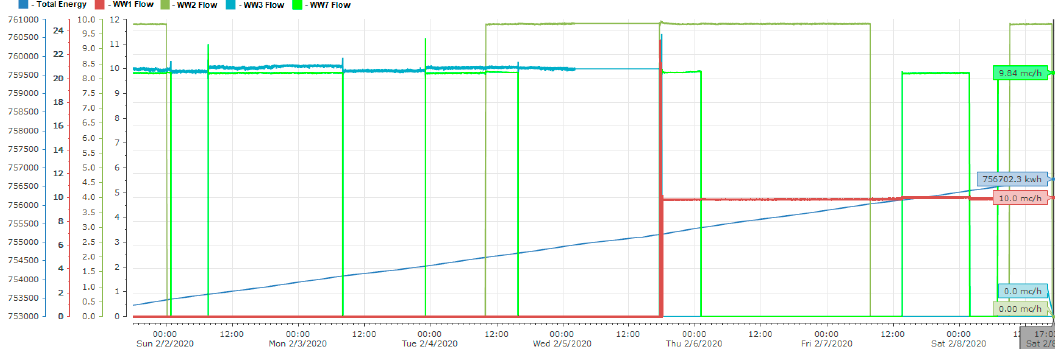
Figure 16. Results without FDC. Well flows (mc/h) and energy consumption (kWh) in Week 4 of tests.